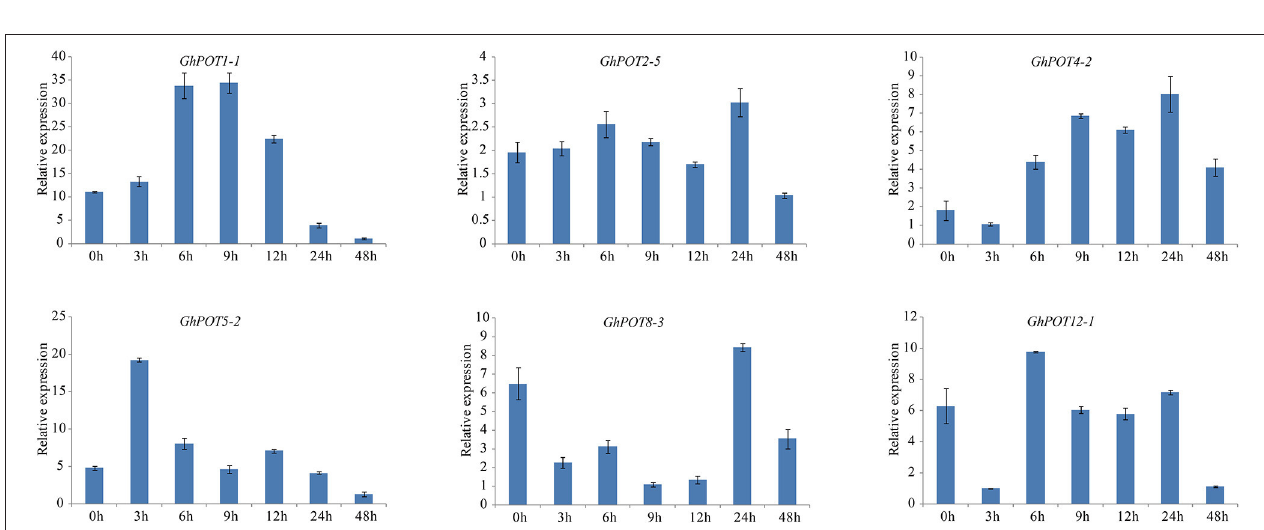
FIGURE 9 | Expressions of GhPOT genes in response to dehydration stress (18% PEG6000). The expressions of GhPOT genes were determined by qRT-PCR using the total RNA isolated from TM-1 leaves at different time points (0, 3, 6, 9, 12, 24 and 48h) of salt stress. The error bars indicate the standard error (SE) of three biological